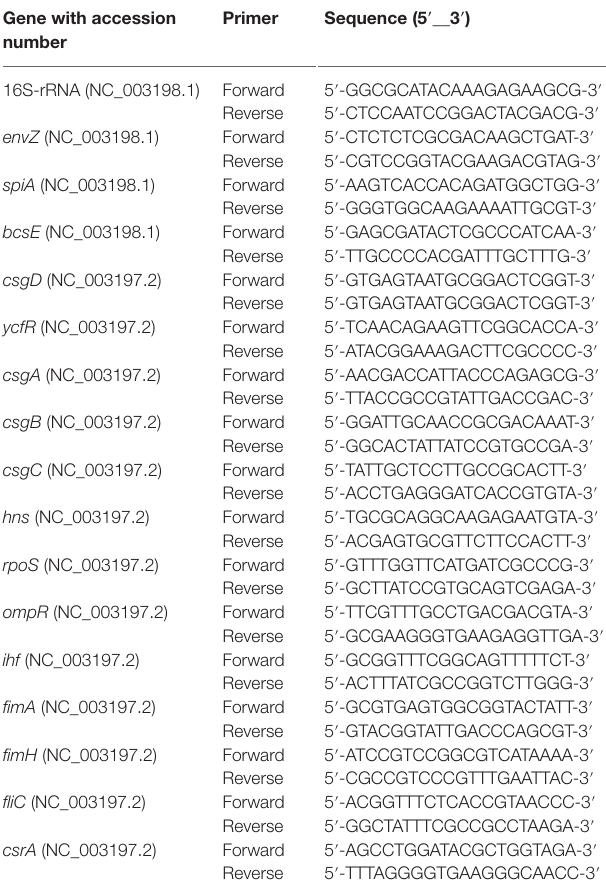
TABLE 1 | List of primers used in this